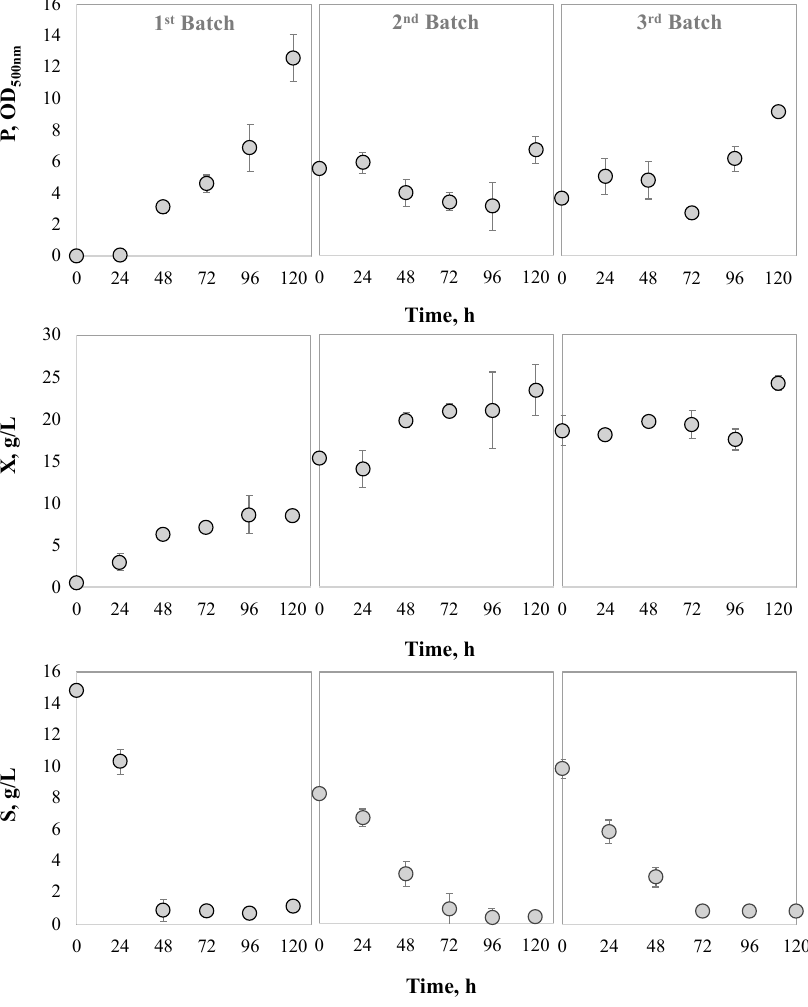
Figure 6. Kinetics of the immobilized cells of Talaromyces atroroseus GH2 in three consecutive batches. Pigments (P), biomass (X), substrate (S). Error bars depict the standard deviation between three replicates.